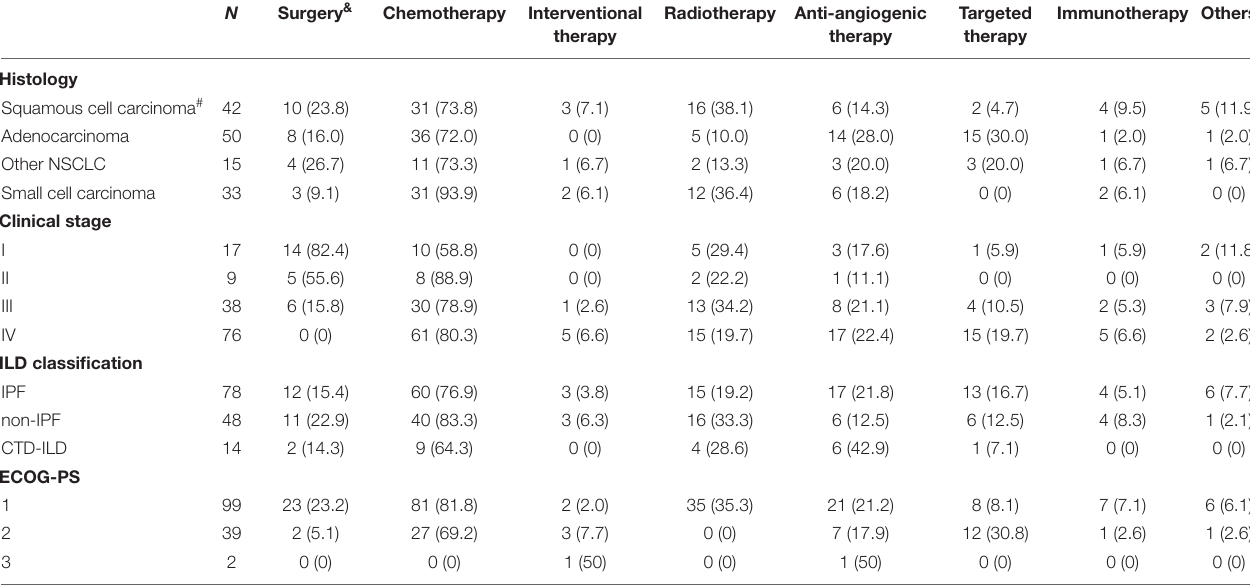
Radiotherapy Anti-angiogenic Targeted Immunotherapy therapy therapy therapy